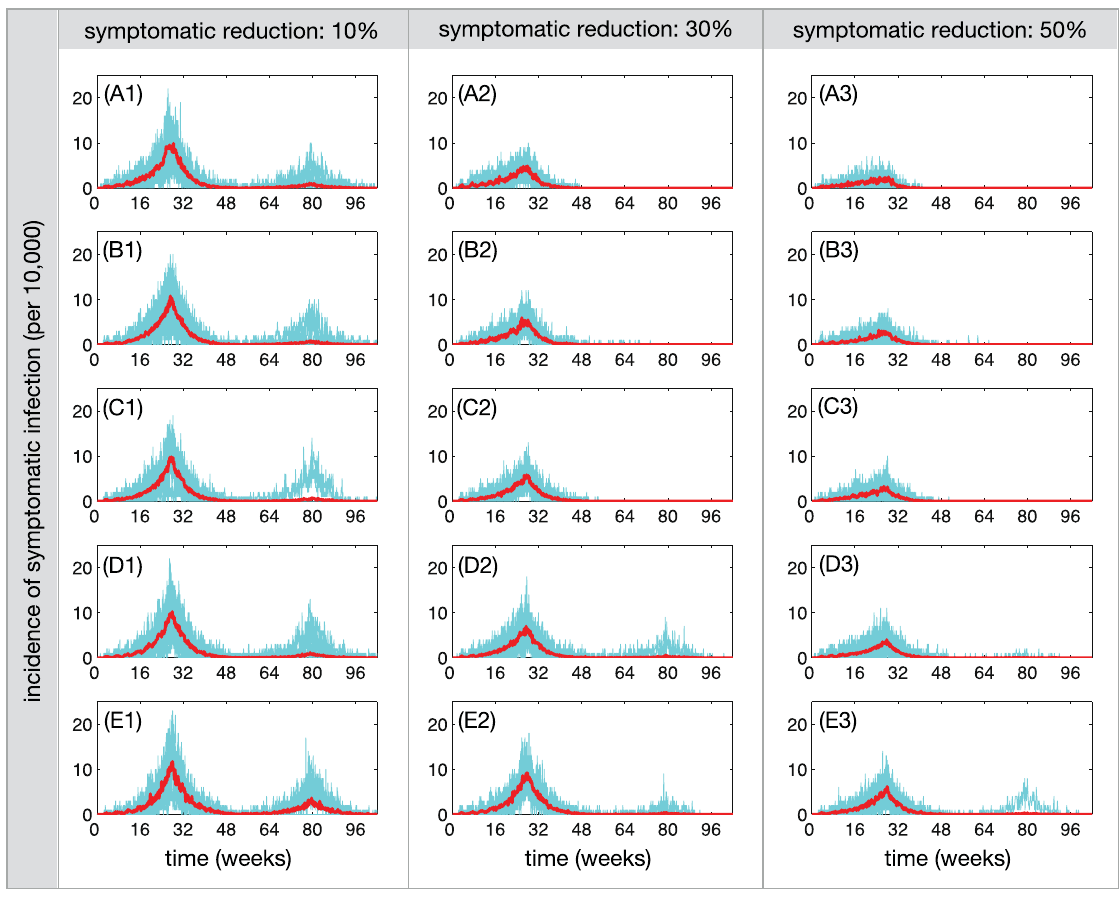
Figure 1. Incidence of symptomatic ZIKV infection over a 2-year period for the first and second waves, when the contribution of symptomatic ZIKV infection to disease transmission through mosquitoes was reduced by 10% (A1–E1), 30% (A2–E2), and 50% (A3–E3). The relative transmissibility of asymptomatic infection is 10% (A1,A2,A3), 30% (B1,B2,B3), 50% (C1,C2,C3), 70% (D1,D2,D3) and 90% (E1,E2,E3). The red curve represents the average of sample realizations for incidence curves.